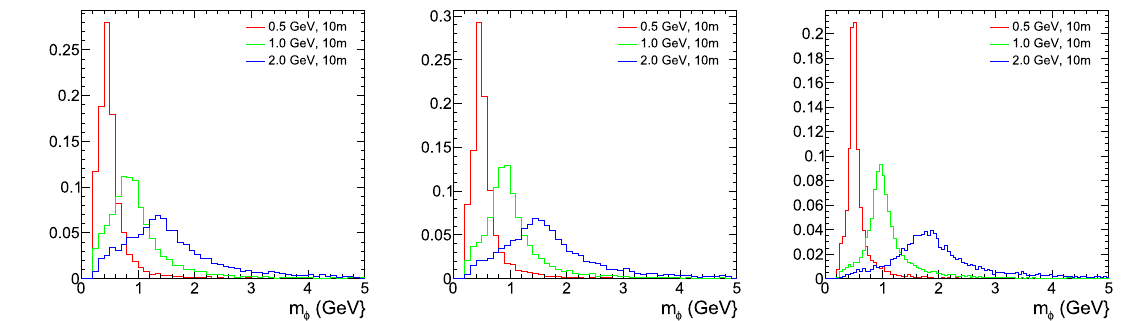
Fig. 33 Reconstructed LLP mass for different B → X s ϕ benchmarks with c τ = 10 m, for 150 ps (left), 100 ps (middle), and 50 ps (right) timing